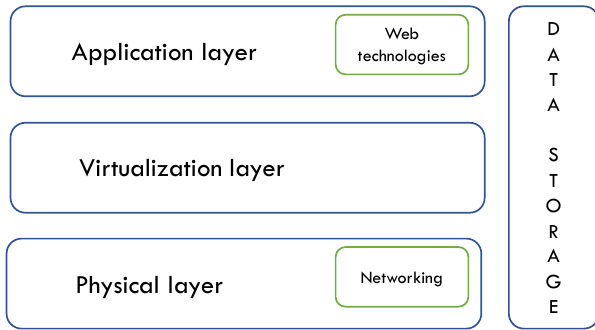
Figure 4. Simplified Cloud reference architecture.